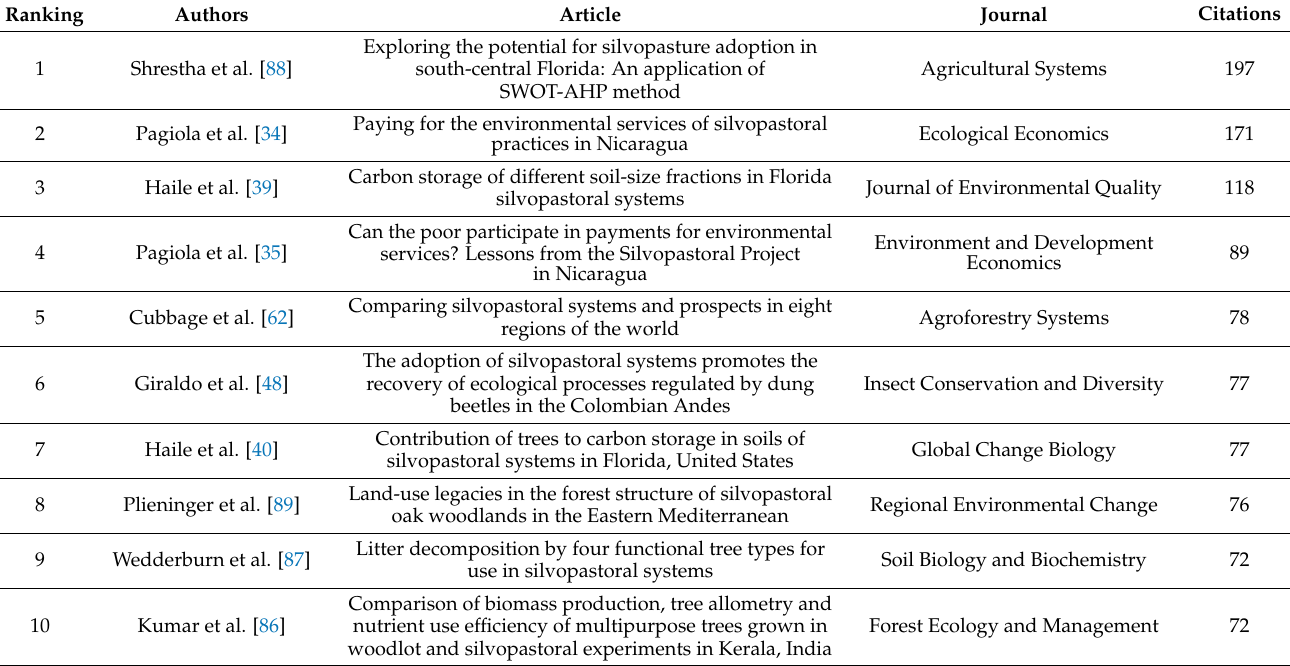
Table 3. Top 10 most cited papers on silvopastoral systems from 1983 to 2022 with 1023 citations, representing 1.07% of the total